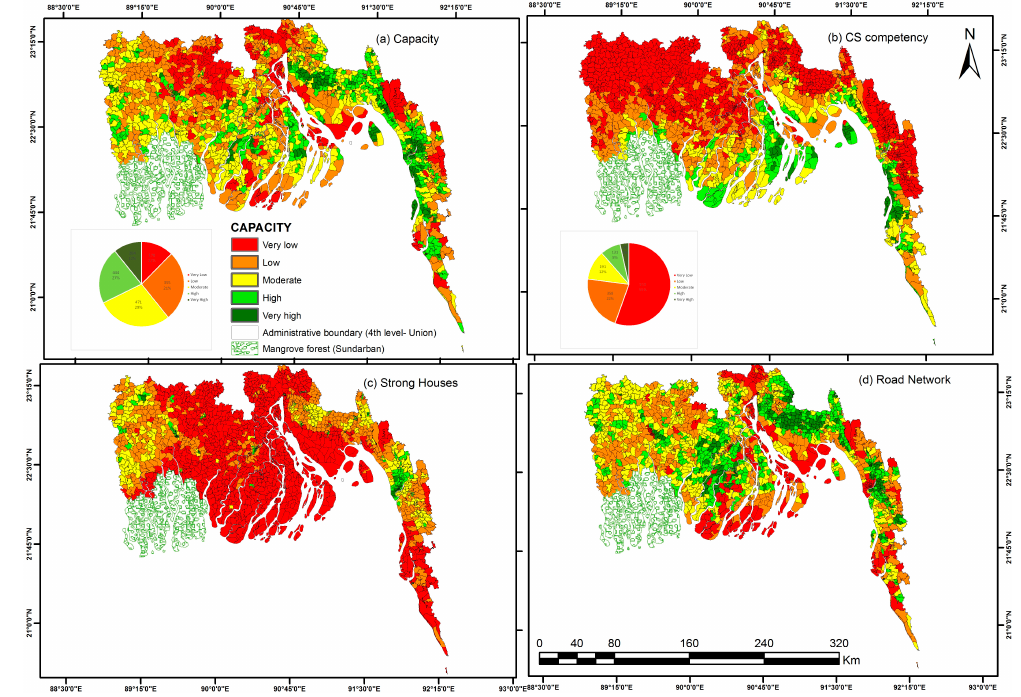
Figure 5. Capacity Index Map of the study area. ( a ) The Capacity index has been calculated by weighted (equal weight) sum of: ( b ) the cyclone shelter competency index; ( c ) the proportion of strong houses; and ( d ) the road network density. Cyclone shelter competency index of each union has been built using cyclone shelter related indicators.